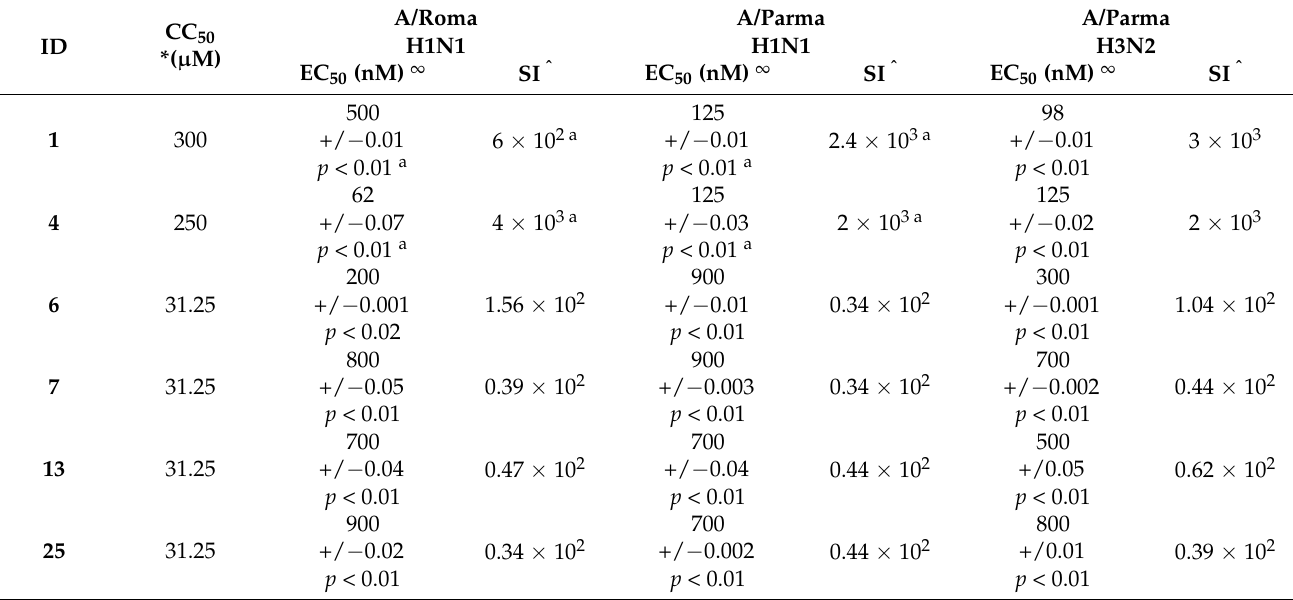
Table 3. In vitro antiviral activity of broad-spectrum